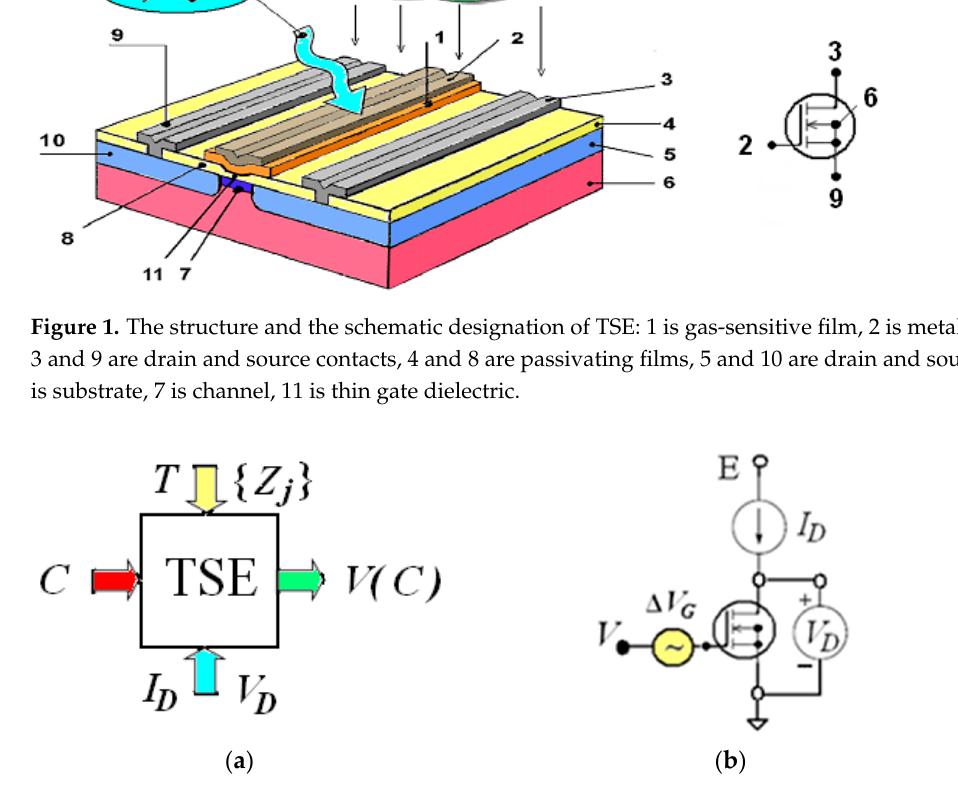
Figure 2. ( a ) The input informative parameter is the gas concentration C ; the output informative parameter is the voltage of the output signal V ; the operating chip temperature is T ; the parameters of the electrical mode of the circuit are the current I D and the voltage V D ; external influencing factors { Z j } are molecules of other gases, temperature, humidity and radiation background of the environment. ( b ) The circuit for measuring the dependence V as function of C .